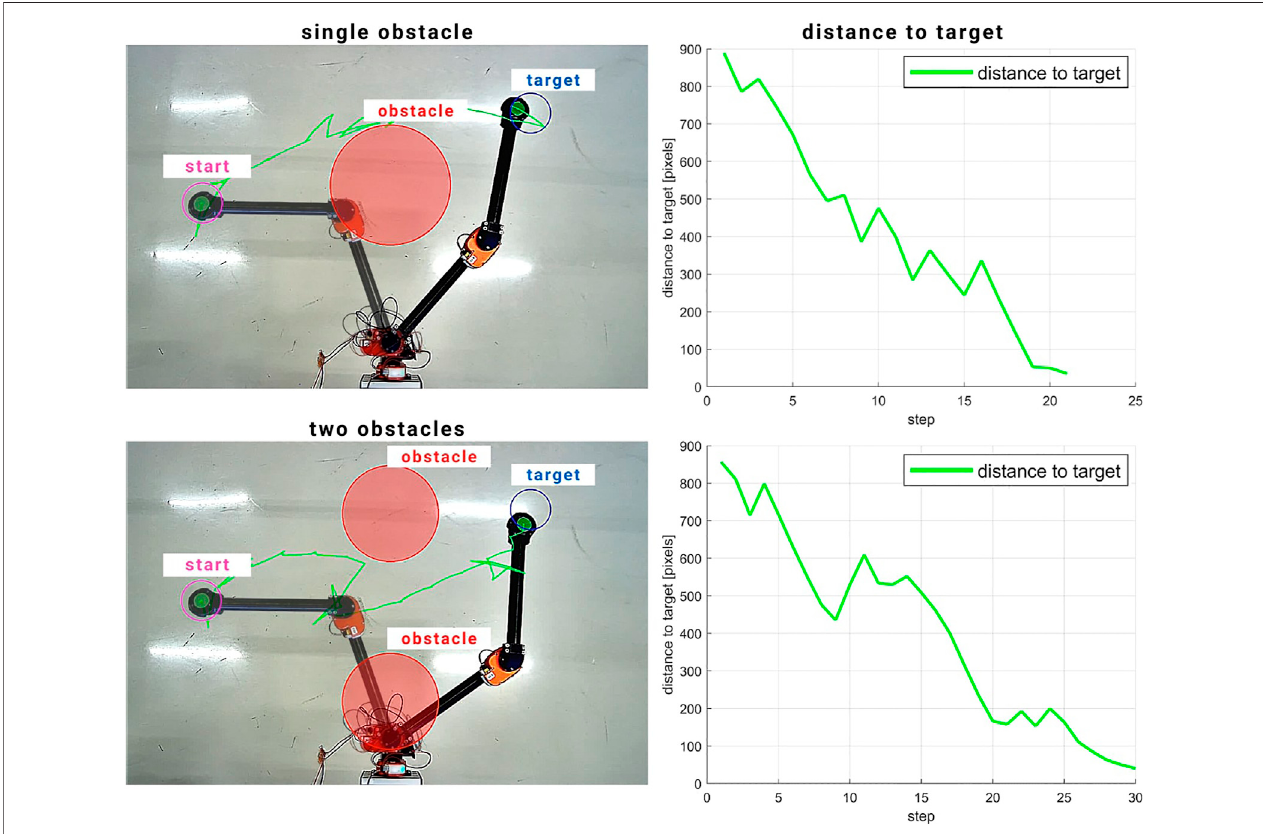
FIGURE 4 | Physical experiment results of KMF-PC reaching and obstacle avoidance. In both cases, the end effector reached close to the obstacle. As such, obstacle in fl ation is recommended. In the single obstacle scenario, the robot reached the target in 21 steps. In the two obstacles scenario, it reached the target in 30